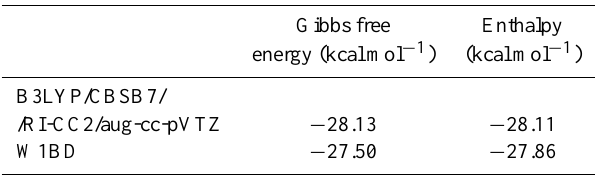
Table 3. The Gibbs free energy and enthalpy of the proton